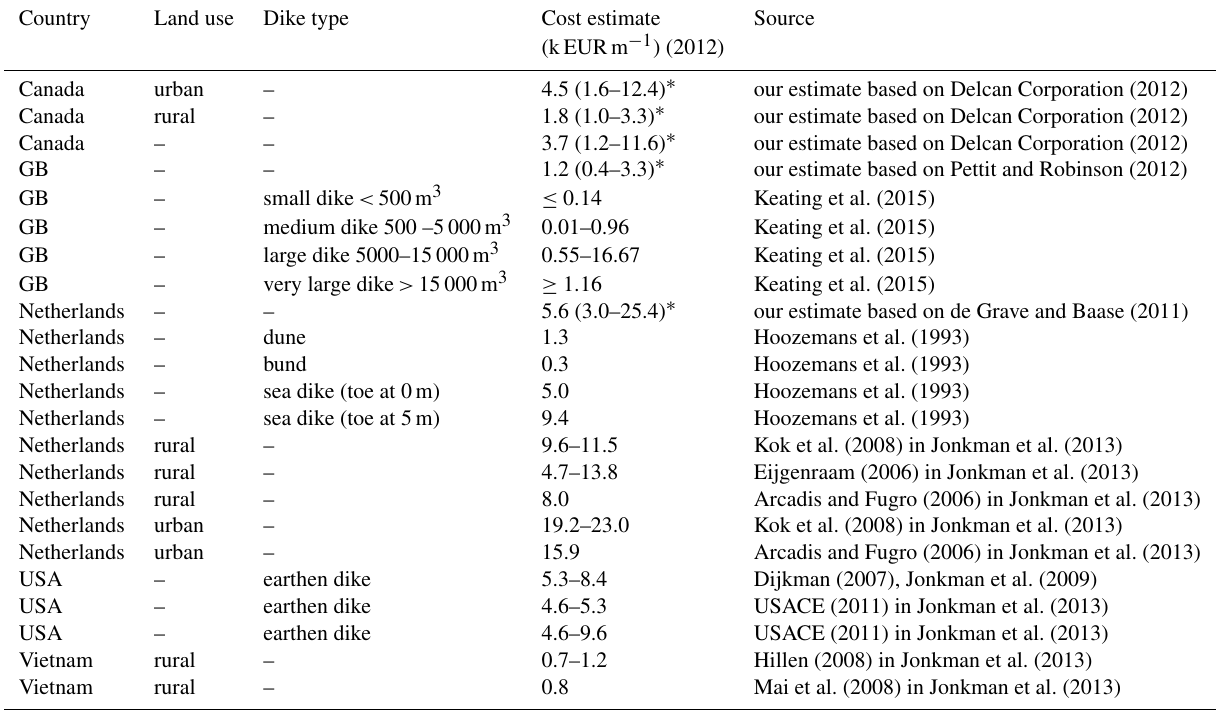
Table B1. Comparison of different cost estimations for raising a dike of length 1km for a height of 1m for different land uses and differ- ent dike types. Land use and dike types are labelled here when available. All values have been converted into 2012 Euros to make them comparable. See also Figure 3 in the main